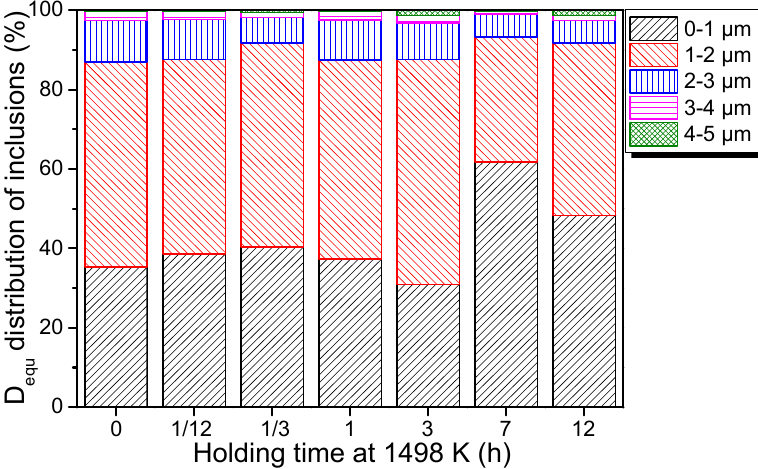
Figure 10. Variation in the average diameter of inclusions in the steel during heat treatment at 1498 K.